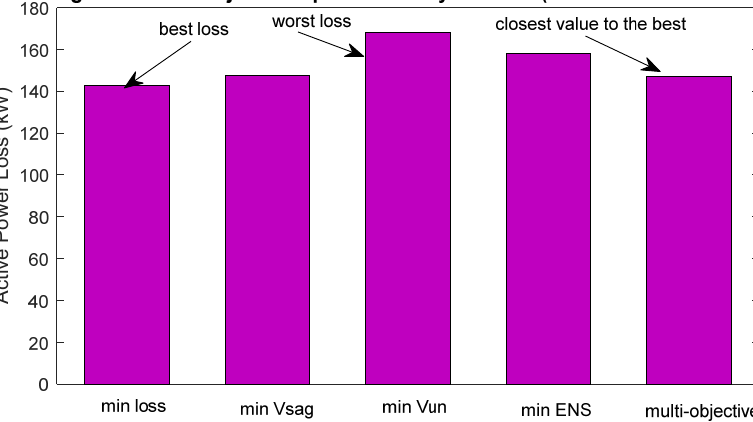
Figure 6. The power loss in single-criterion and many-criteria optimizations using AEFAPS.